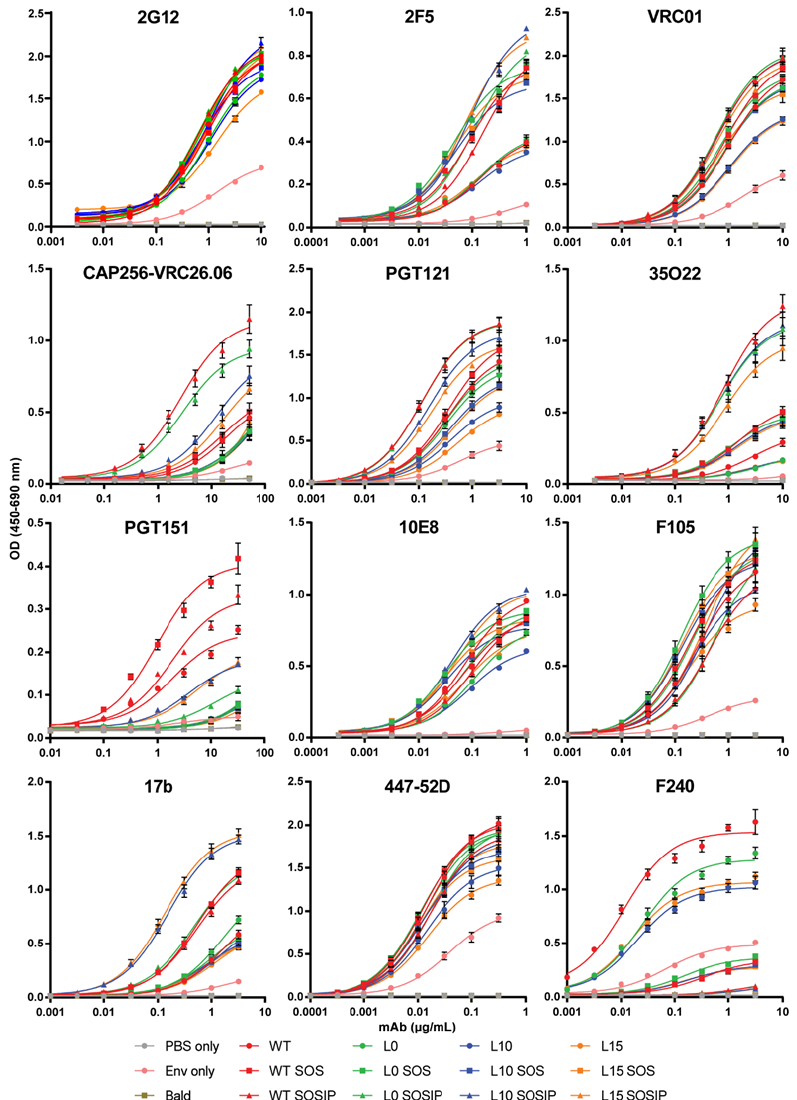
Figure 3. Comparison of neutralizing and non-neutralizing antibody binding to mVLP-associated linker-stabilized Env. VLP ELISA binding curves of bNAbs (2G12, 2F5, VRC01, CAP256-VRC26.06, PGT121, 35O22, PGT151, 10E8) and non-neutralizing mAbs (F105, 17b, 447-52D, F240) to a buffer- only control (PBS only), mVLP ∆ env that does not present Env on its surface (Bald), mVLP ∆